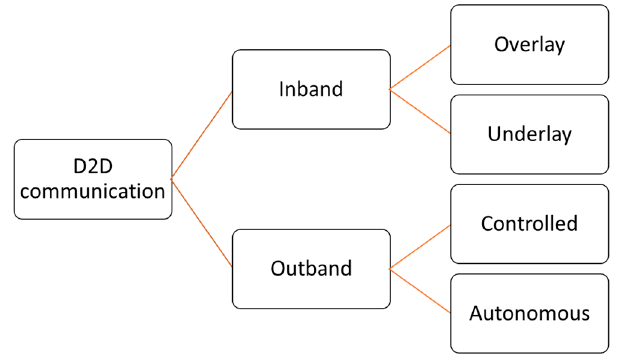
Figure 1. Types of D2D communication.